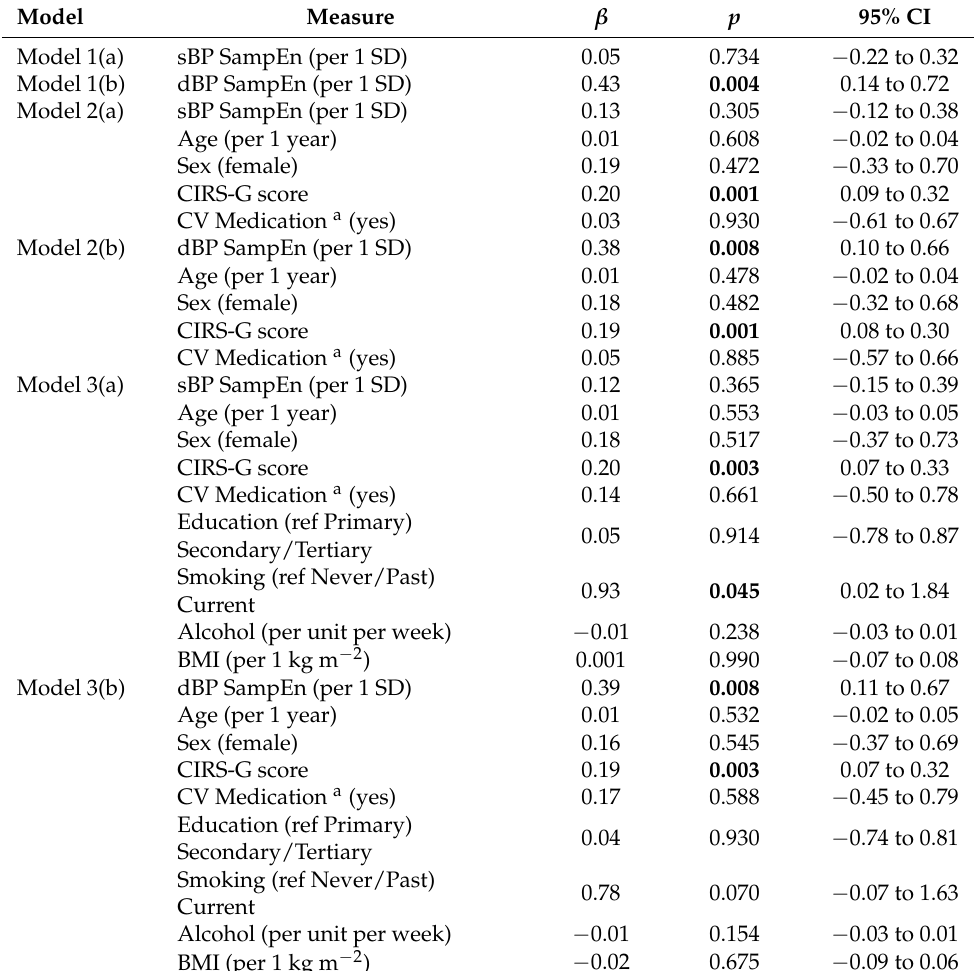
Table 2. Results from robust linear regression models investigating the relationship between SHAR- FI score and BP sample entropy (SampEn). Three sets of models were used: Model 1, unadjusted (bivariate); Model 2, adjusted for basic demographics and health measures (age, sex, CIRS-G score, and cardiovascular medication use); and Model 3, additionally adjusted for lifestyle socioeconomic factors (age, sex, CIRS-G score, cardiovascular medication use, educational attainment, smoking status, alcohol consumption, and BMI). All SampEn measures were standardized (z-scores) prior to analyses. Results from absolute coefficients are reported as point estimates ( β coefficients) in appropriate units and presented with 95% CI. Statistical significance was set at p <